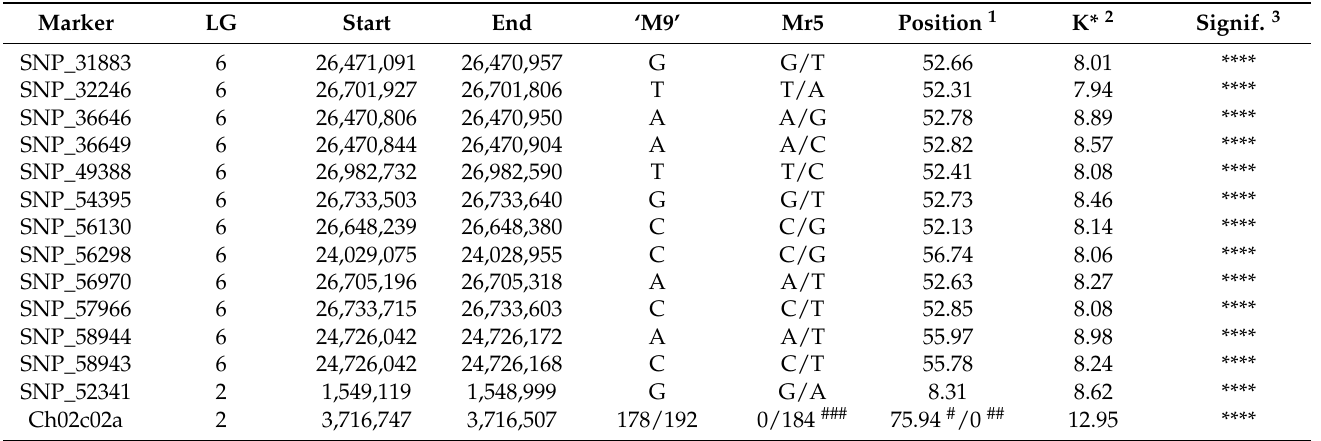
Table 2. Summary of the significant SNP and SSR markers detected by the Kruskal–Wallis test (KW) and their position on the linkage group for